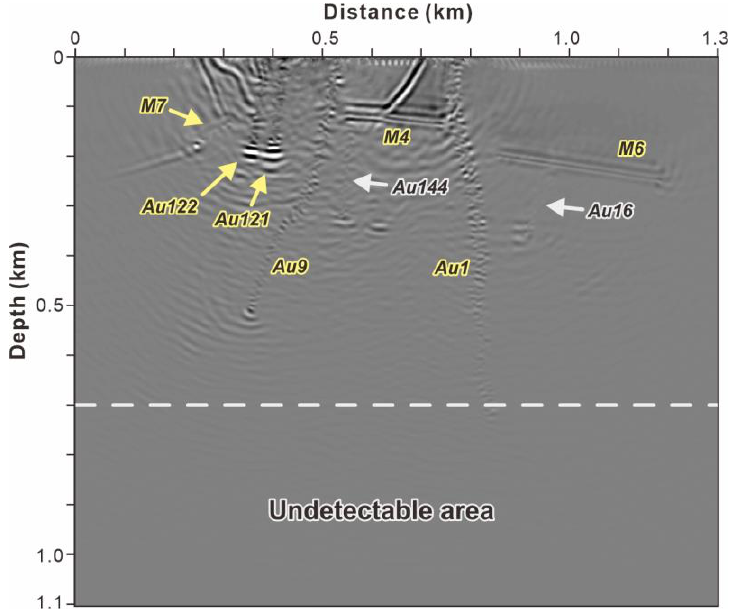
Figure 9. RTM imaging result of the Zaozigou model. Orebodies with yellow margin were success- fully imaged in our experiment, while orebodies with white margin failed to be imaged.